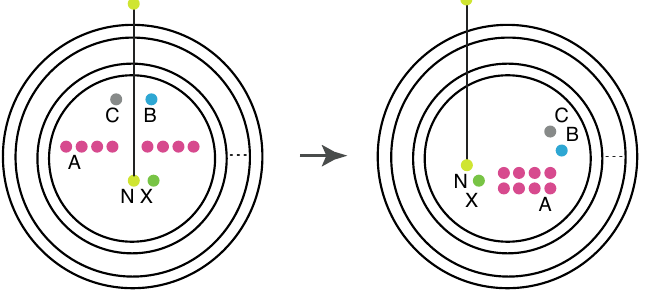
Figure 44 . 6d [1 A ; 8] (cid:0) SU(1) (cid:0) SU(1) (cid:0)(cid:1) (cid:1) (cid:1)(cid:0) SU(1) (cid:0) [1] giving 5d Sp( n ) with N f = 8 and N a = 1. From the (cid:12)gure on the right of (cid:12)gure 43, one moves B 7-brane along the direction of the charge (1 ; 1) so that the B brane comes a freely (cid:13)oating 7-brane. This procedure gives a con(cid:12)guration (cid:0) on the left here. Using the 7-brane monodromy, one can put all the 7-brane on one side like the (cid:12)gure on the